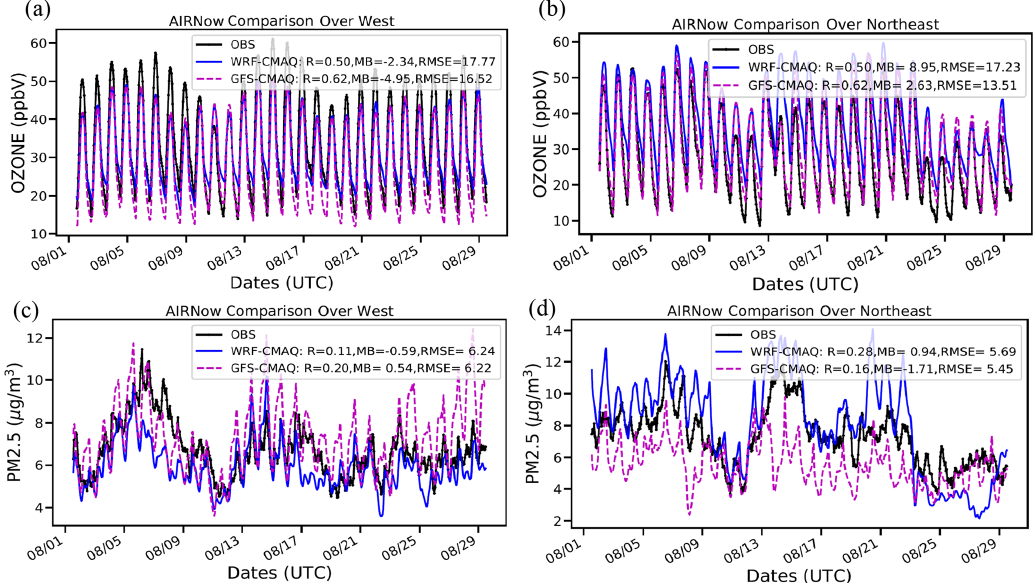
Figure 4. Same as Fig. 3 but for O 3 (a, b) and PM 2 . 5 (c, d)